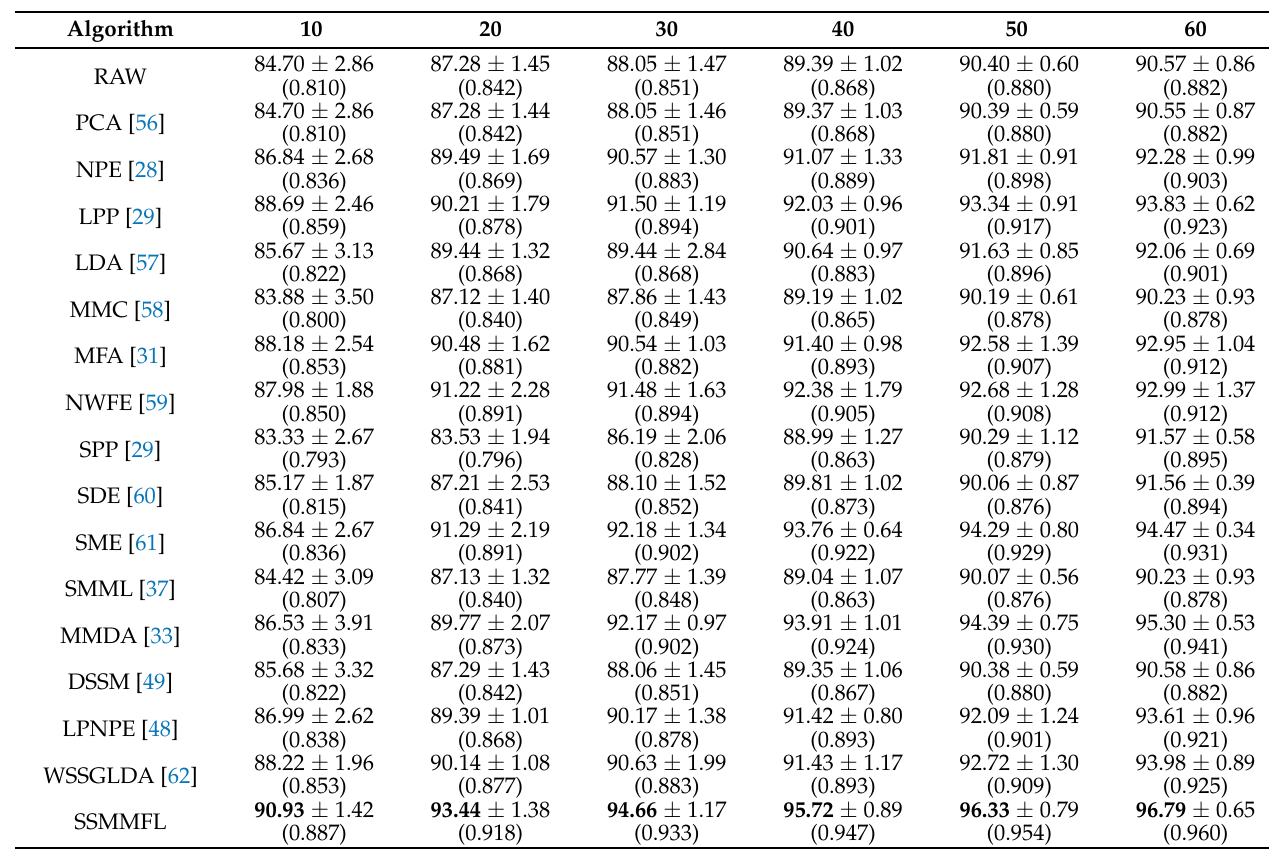
Table 3. Classification results with different values of n i on the Washington DC Mall dataset with NN classifier. Each method has two rows, where the first row is the OA ± STD (%) and the second row is the